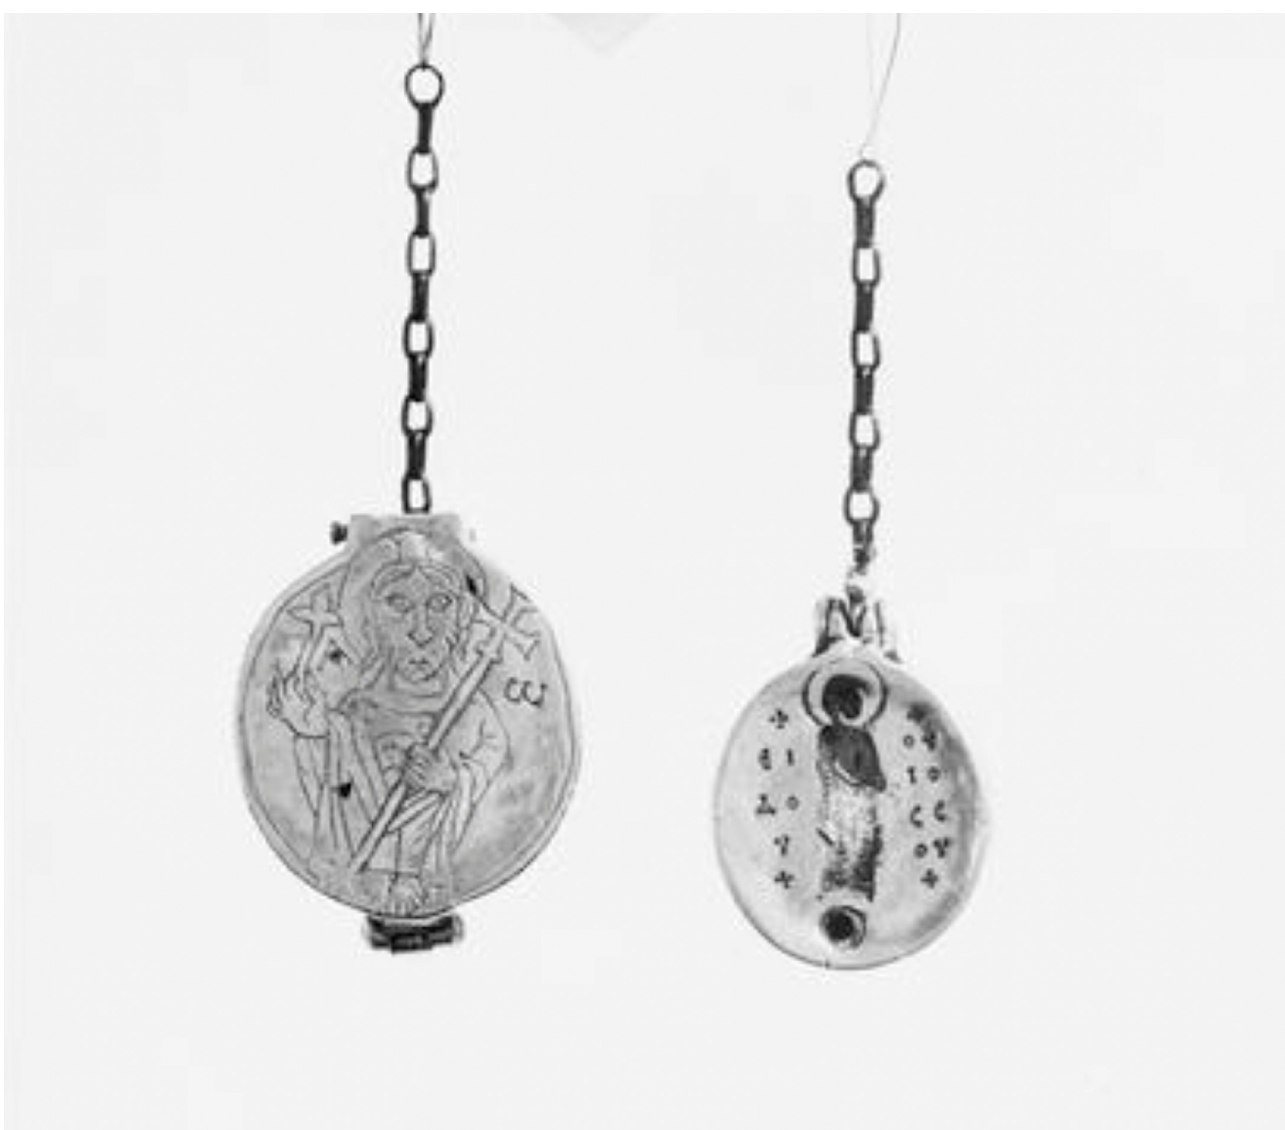
Figure 4. Outer and inner reliquary capsules associated with the sainte Vertu. Left: silver gilt and niello, late eleventh century. Right: silver gilt, niello and enamel, Byzantine, eleventh century or earlier, treasury of the abbey Saint-Sauveur de Charroux (Photo by permission: Ferron © Ministère de la Culture, Médiathèque du patrimoine et de la photographie, diffusion. RMN-GP).